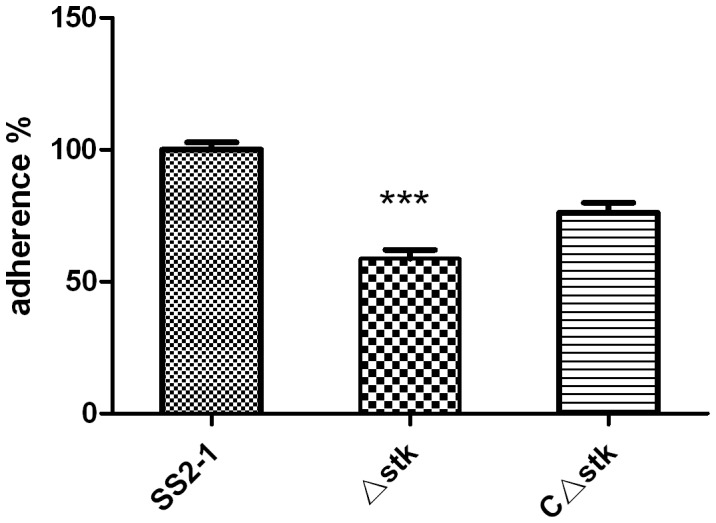
Effects of stk on SS2 adherence to HEp-2 cells.The mutant strain Δstk showed significant reduced levels of adherence to HEp-2 cells compared to the adherencity of the parental strain SS2-1 (***p<0.001).